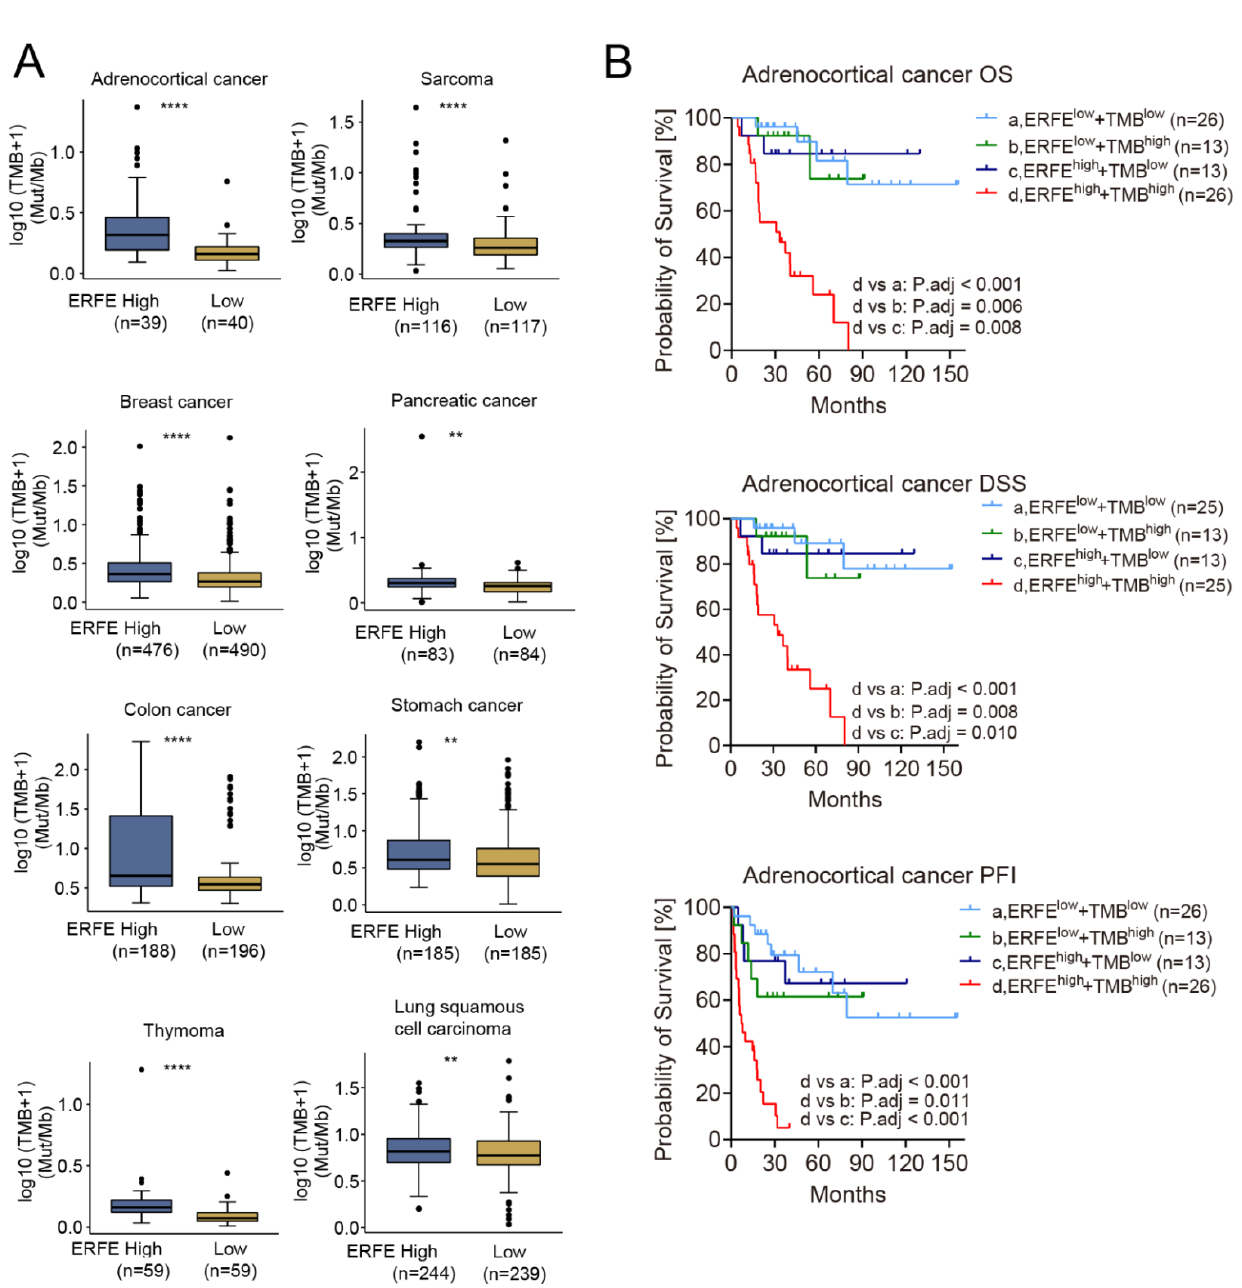
Figure 4. Correlation of ERFE expression status with TMB. ( A ) Comparison of TMB between ERFE high and ERFE low patients in pan-cancer. Wilcoxon rank sum test was performed. ** p < 0.01; **** p < 0.0001. ( B ) Patients with different levels of ERFE expression and TMB were stratified into groups of ERFE low TMB low , ERFE low TMB high , ERFE high TMB low , and ERFE high TMB high in adrenocortical cancer. The survival subgroup analysis was analyzed by Log-rank test with multiple comparisons for calculating adjusted p -values.